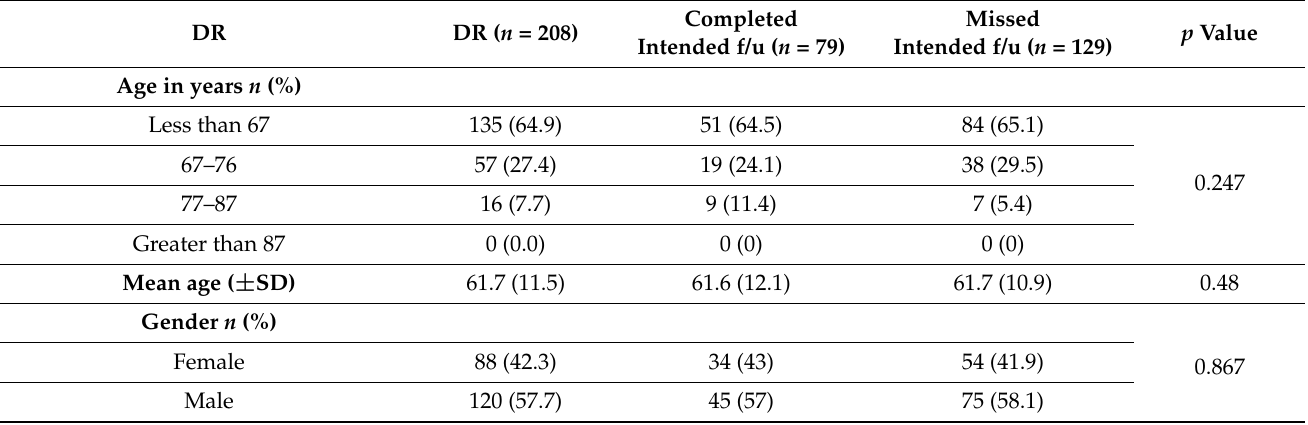
5 letters. Table 3. Demographic and clinical characteristics of DR